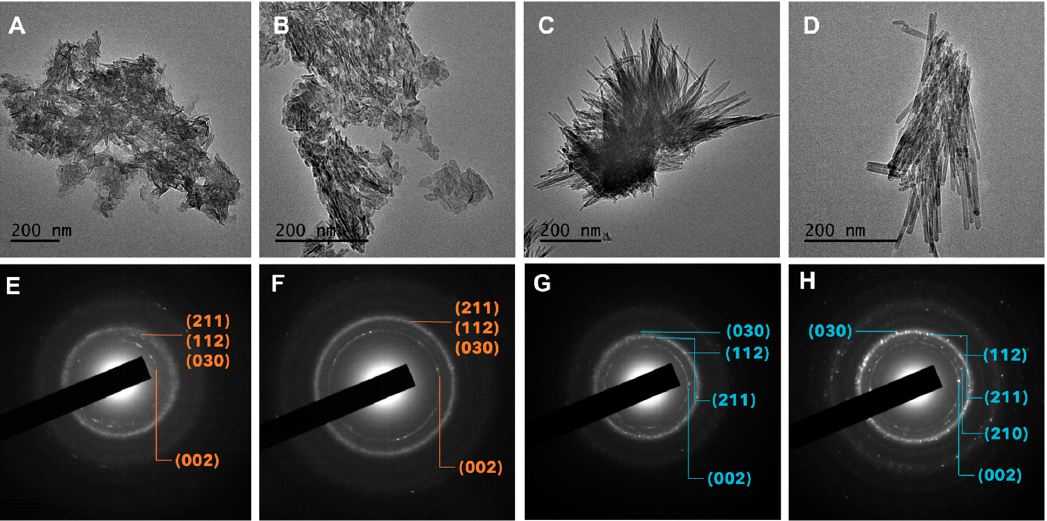
Figure 5. ( A – D ) Selected TEM micrographs and ( E – H ) SAED patterns recorded on substituted HAP synthesized via homogeneous enzymatic catalysis at 37 °C, pH 7.4 using ( A , E ) [S] 0 = 1.0 mM, [F − ] 0 = 0; ( B , F ) [S] 0 = 7.0 mM, [F − ] 0 = 0; ( C , G ) [S] 0 = 7.0 mM, [F − ] 0 = 0.25 mM; ( D , H ) [S] 0 = 7.0 mM, [F − ] 0 = 1.0 mM.